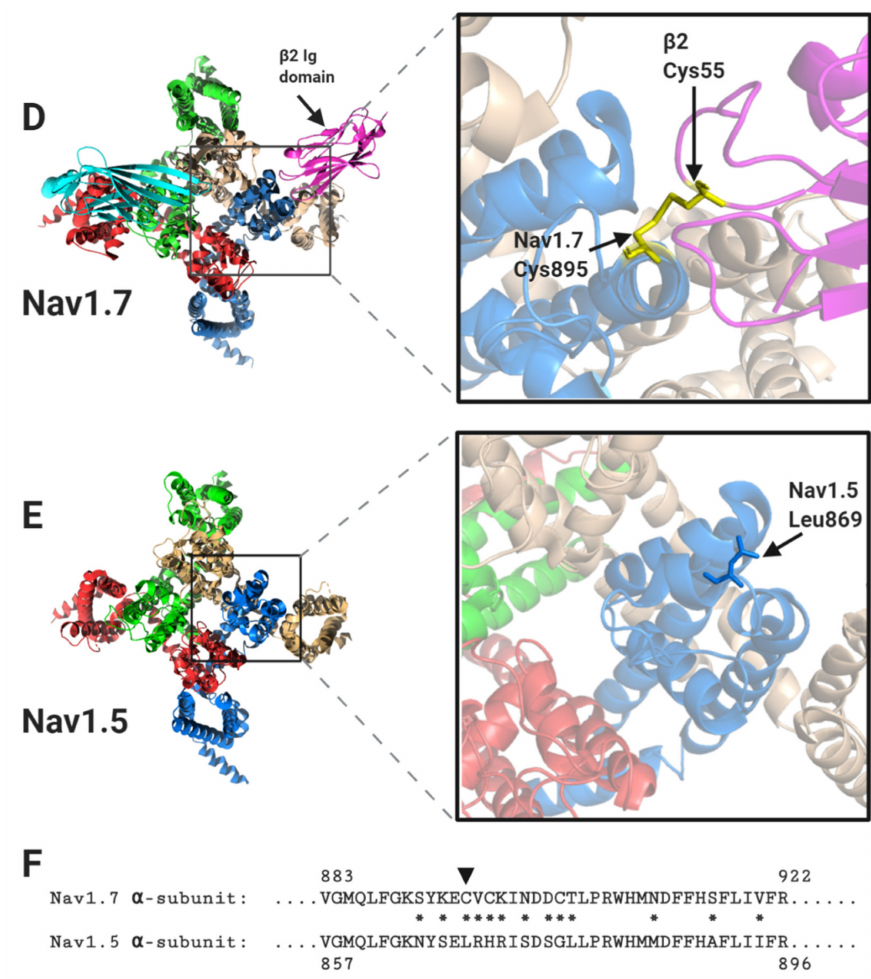
Figure 4. The binding sites for β 1 and β 2 on the Nav1.7 α -subunit and its comparison with Nav1.5. ( A ) Side views, each with 90 ◦ rotation, of the Nav1.7 α -subunit, with associated β 1 and β 2 -subunits. ( B ) Top view of the Nav1.7 α -subunit, with the β 1 Ig domain binding site on the DI, DIII and DIV extracellular loops highlighted. ( C ) Top view of the equivalent region of Nav1.5 α -subunit. Resolved electron density corresponding to the N-linked sugar residues mentioned in the text are shown in grey dots. ( D ) Top view of the Nav1.7 α -subunit with the β 2 Ig domain binding-site on DII extracellular loop highlighted. ( E ) Top view of the equivalent region of the Nav1.5 α -subunit. ( F ) Sequence alignment of human Nav1.7 and Nav1.5 α -subunits around the DII β 2 binding-site. Amino acid di ff erences between the two sequences are indicated by asterisks. The position of the Cys895 residue in Nav1.7, noted in the text, is indicated with an